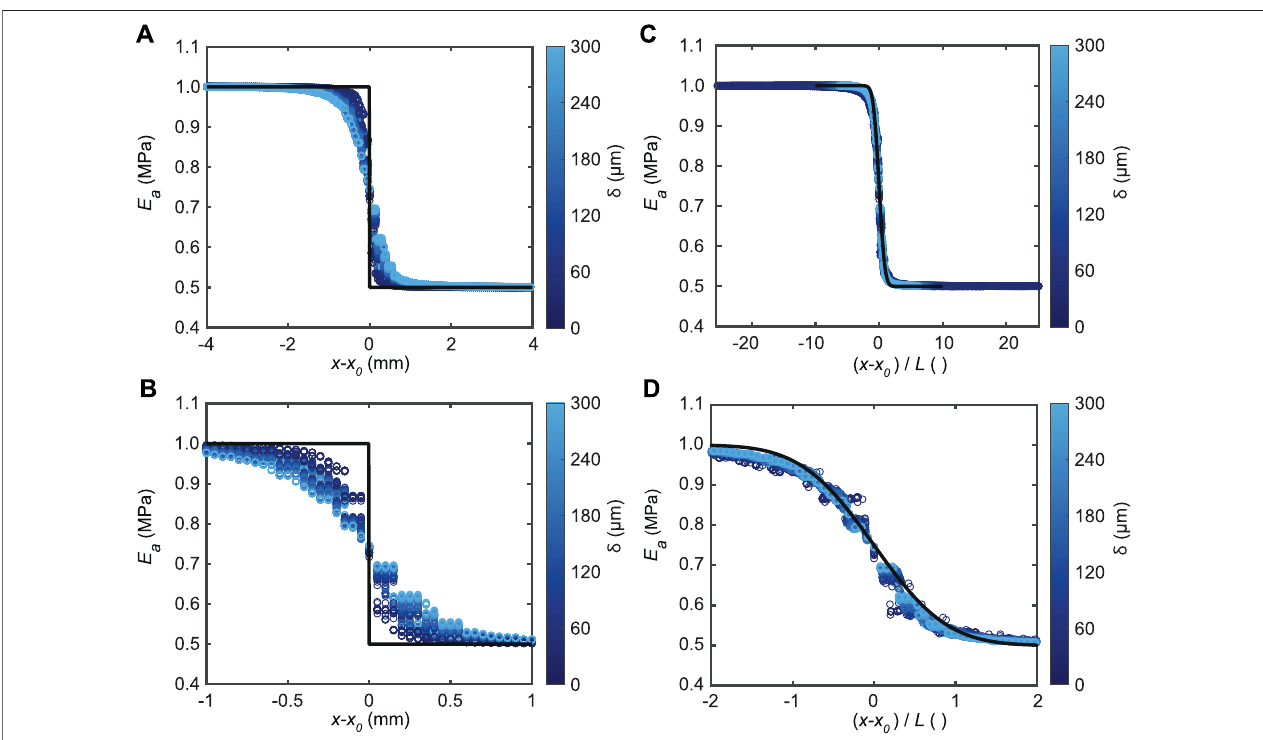
FIGURE 3 | FEM simulation data for a step modulus pro fi le for all three probe radii. (A) E a at all simulated depths δ (color coded) plotted versus the probe position from the interface ( x − x 0 ) for a step pro fi le obtained by Eq. 2a (black), with (B) a zoom-in of panel (A) showing the data around the interface. (C) E a from panels (A) and (B) plotted versus the probe position from the interface ( x − x 0 ) rescaled with L , where the black line represents E c from Eq. 5 , with (D) a zoom-in of panel (C) showing the data around the